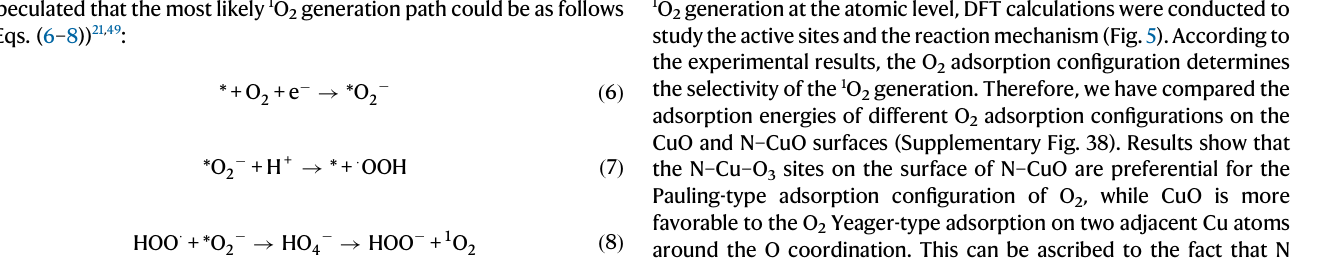
standard deviation from triplicate experiments. e EPR spectra for the detection of (cid:129) − in the presenceof DMPO(50mmolL − 1 ). f EPRspectraof ECsystem with (cid:129) OOH/O 2 different sacri fi cial agents by using N –